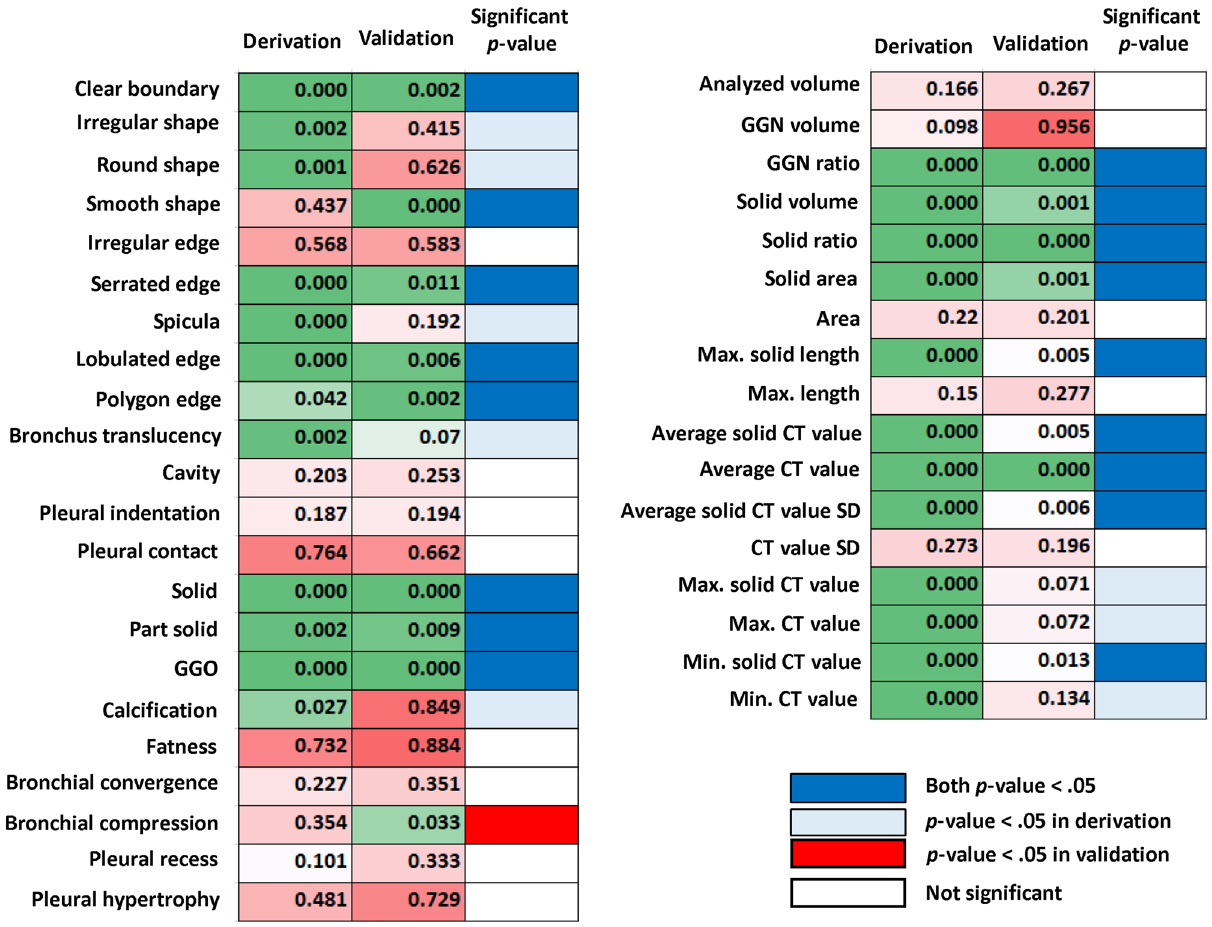
Figure 3. Heat map showing the p -value significance of correlations between the 39-feature signatures and pathological lymph node metastasis. Artificial intelligence imaging analysis indicates the signatures related to lymph node metastasis in the derivation and validation